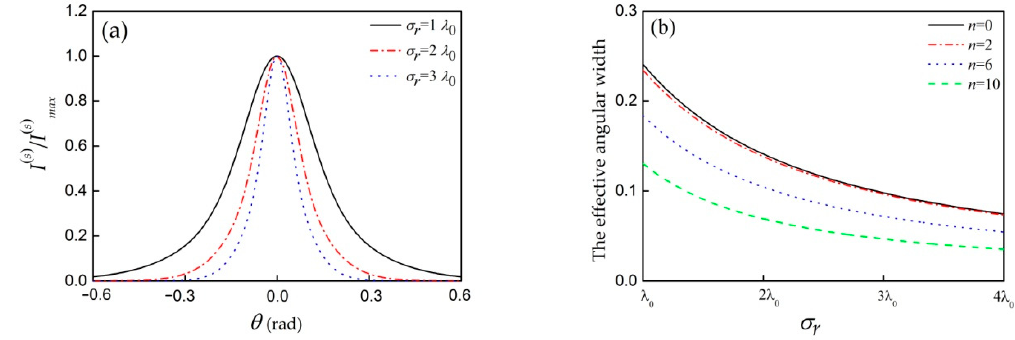
Figure 6. ( a ) Normalized intensity of scattered pulse against scattering angle θ for three different values of correlation length σ r of medium. ( b ) Effective angular width of scattered pulse against correlation length σ r of medium.